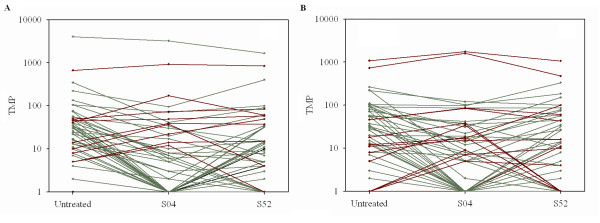
Expression patterns of (A) orthologous and (B) paralogous CNMS (CTT)n/(GAA)n associated genes in Arabidopsis leaves with salicylic acid treatment. Genes were inhibited after 4 hours of treatment with salicylic acid (green), induced after 4 hours of treatment with salicylic acid (red) and kept inactive until 52 hours of treatment with salicylic acid (black). The gene expression levels were estimated by Arabidopsis MPSS data from three different libraries generated by untreated leaves and treated leaves 4 (S04) and 52 hours (S52) after salicylic acid treatment, respectively. TPM is normalized value in transcripts per million for each signature in the library.